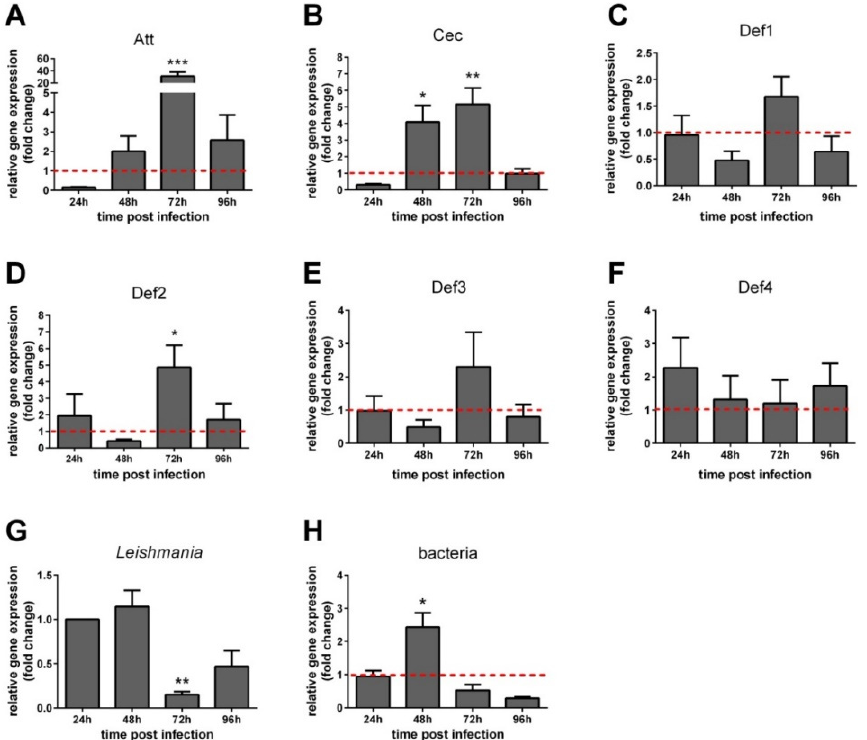
Figure 3. Relative gene expression of AMPs in blood-fed females infected by Leishmania . ( A ) Att; ( B ) Cec; ( C ) Def1; ( D ) Def2; ( E ) Def3; ( F ) Def4; ( G ) Leishmania actin; ( H ) bacteria 16S ribosomal RNA. The y -axis represents relative gene expression as fold change values, in comparison to the control group of blood-fed females (dotted line) collected at the corresponding time points ( A – F , H ); Leishmania detection was expressed in comparison to 24 h ( G ). The x -axis represents females collected at first to fourth day PF. Vertical bars represent the average values of three independent experiments, and error bars represent the standard error. Asterisks indicate significant differences (* p < 0.05; ** p < 0.01; *** p < 0.001).